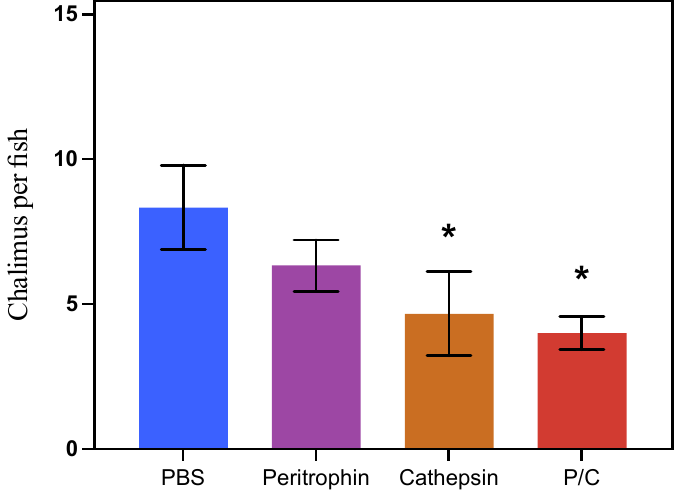
Figure 9. Chalimus I burden per fish in each experimental group. Asterisks showed significant differences concerning the control group (PBS: phosphate-buffered saline) ( p -value < 0.05).